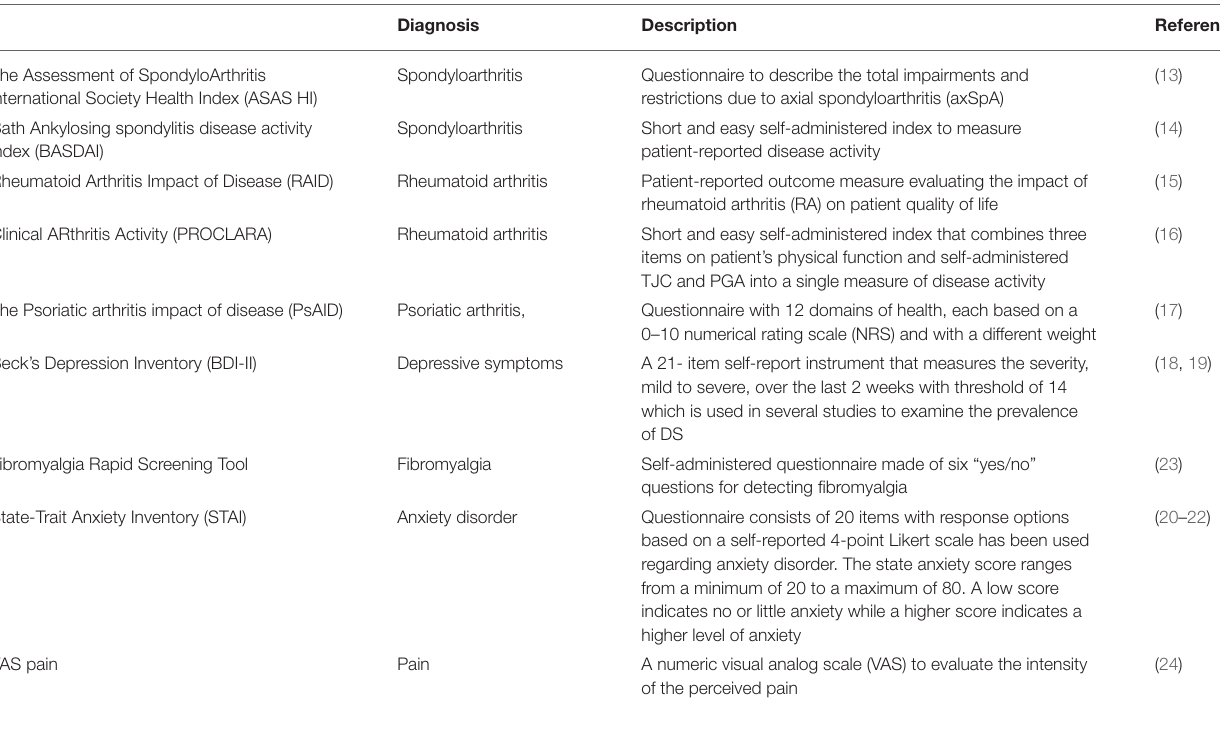
TABLE 1 | Clinimetric questionnaires